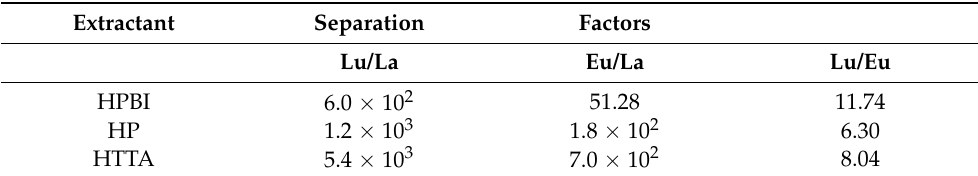
Table 4. Tendencies in the separation of the lanthanoids in their solvent extraction, implementing C 6 H 6